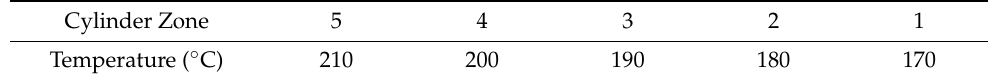
Table 1. Temperature regime of the injection process.